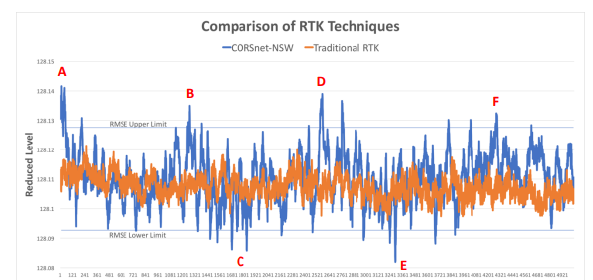
Figure 9: Comparison of levels over 7hrs using of both RTK techniques. Note: RMSe limits are at 95% CI